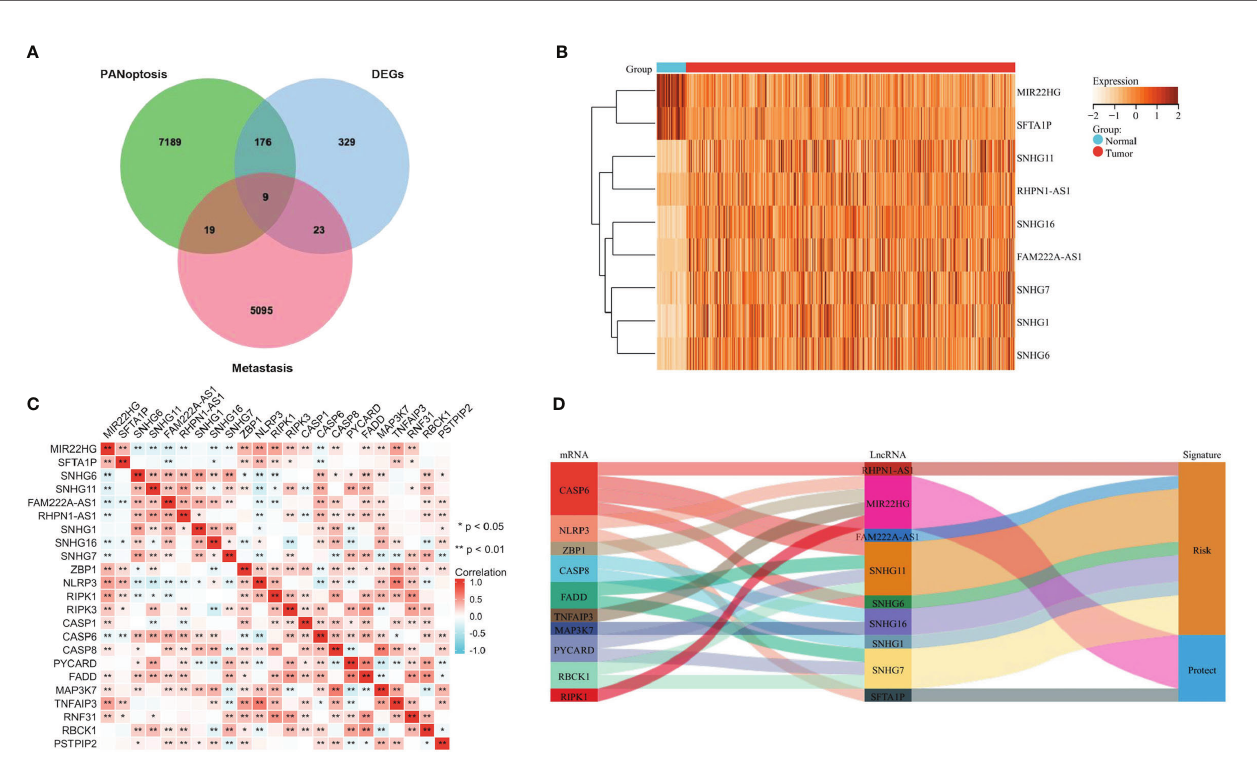
FIGURE 2 | Identifying Metastasis- and PANoptosis-Related lncRNAs in COAD. (A) Venn diagram identifying metastasis-related genes, PANoptosis-related lncRNAs, and differentially expressed genes in TCGA-COAD. (B) Heatmap showing the differential expression of 9 candidate lncRNAs in COAD and adjacent normal tissues. (C) The correlation heatmap showing the correlation between 9 candidate lncRNAs and PANoptosis-related mRNAs. (D) Sankey diagram visualizes the degree of relationship between PANoptosis-related mRNAs, 9 candidate lncRNAs, and COAD